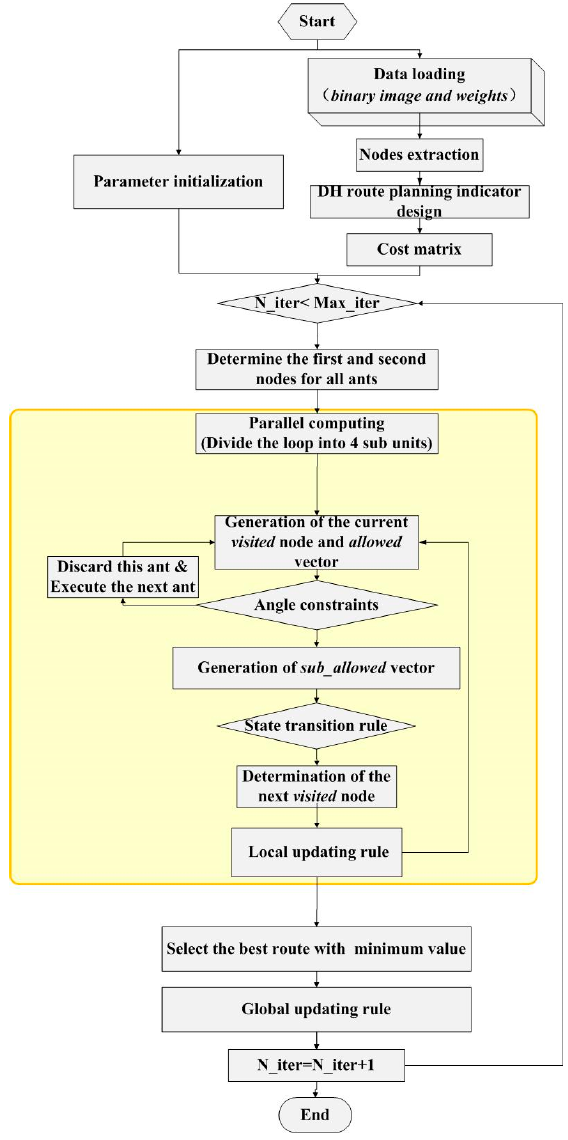
Figure 5. Flowchart of the parallel ant colony system (ACS)